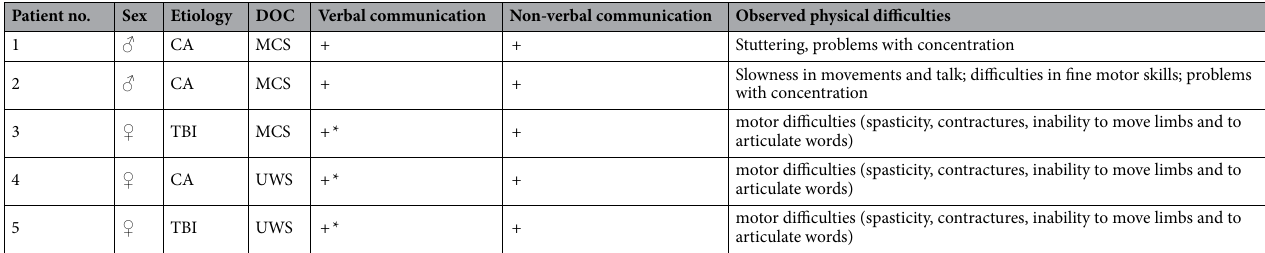
Table 2. Neurocognitive and behavioral assessment of consciousness improved patients after DBS. CA cardiac arrest, TBI traumatic brain injury, UWS unresponsive wakefulness syndrome, MCS minimally conscious state. *Under intensive speech therapy at the moment, able to pronounce simple